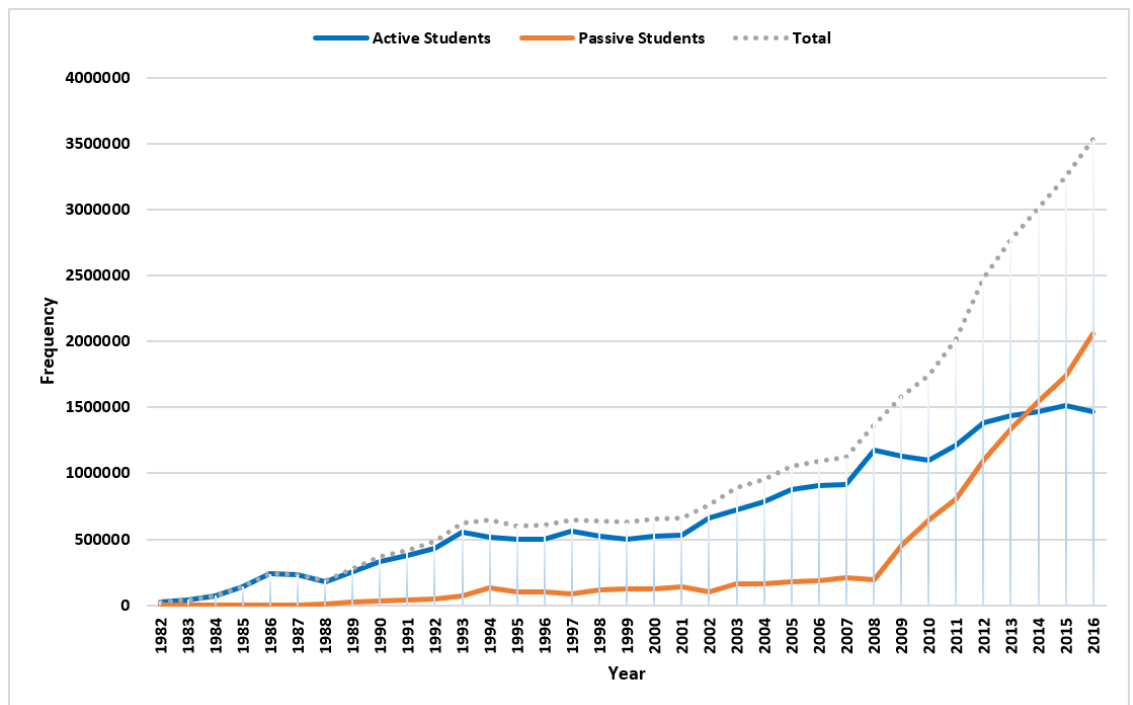
Figure 2. Active and passive student numbers